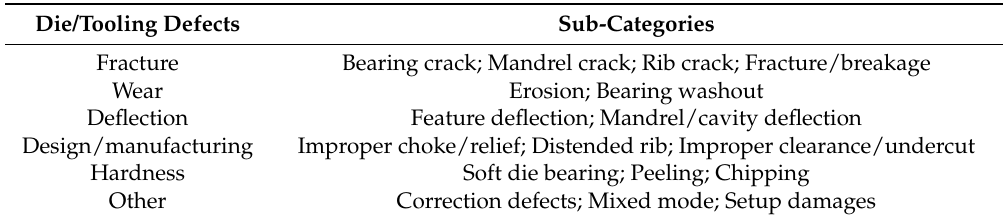
Table 1. Major types of die defects and their common